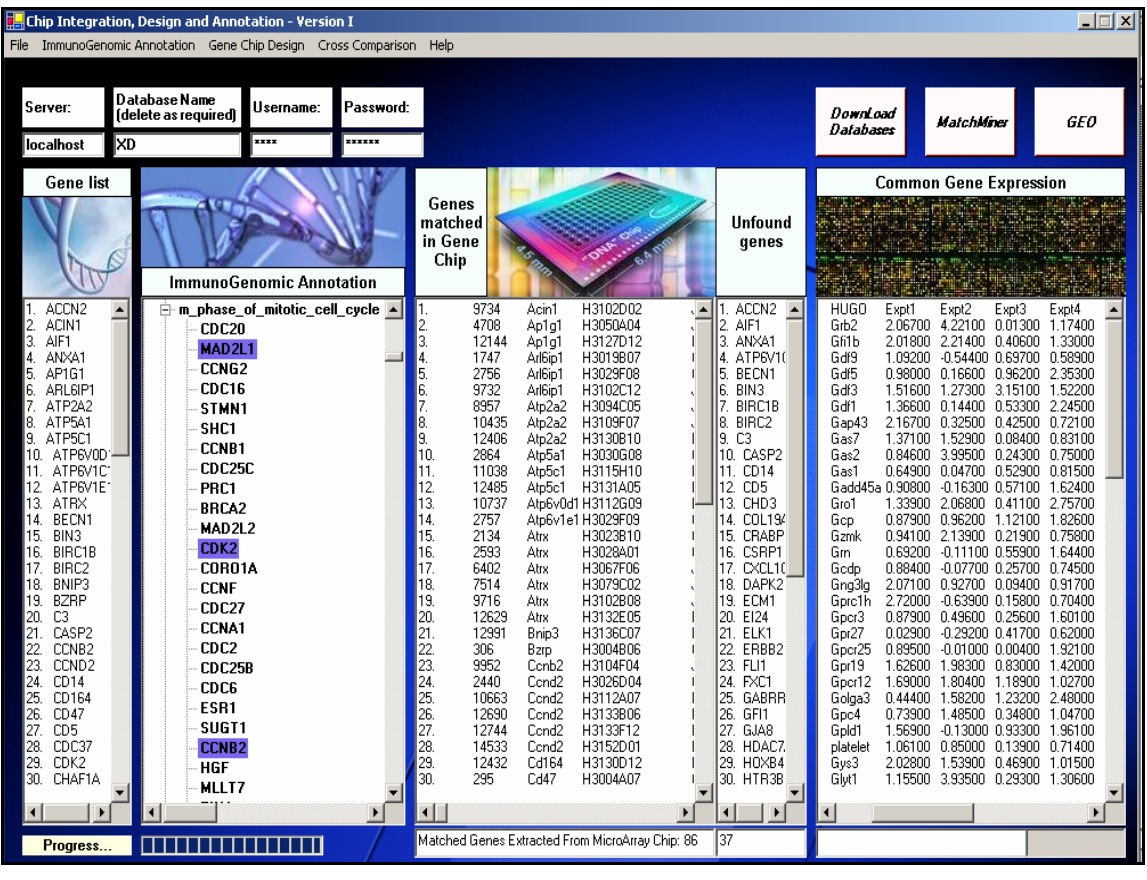
Figure 2: The graphical user interface of CIDA The multi-panelled user interface of the CIDA software allows microarray data interpretation and integration for any gene expression dataset. The immunogenomic annotation panel displays a hierarchical treeview detailing gene functionality for the interesting genes within a biological system under investigation. The third panel utilises an underlying GCD database to store data from an entire clone gene set and aids the design of in-house gene chips for specific research requirements. Upon providing the software with a gene list of interest, CIDA returns the necessary information required for fabricating subsequent gene chips of interest. The final panel integrates multiple related microarray studies displaying common genes possessing potential common roles within the underlying diseases together with their gene expression